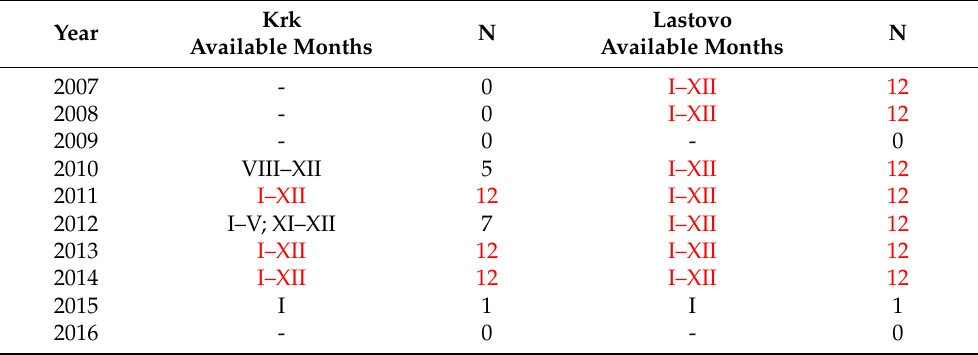
Table 1. Available complete monthly sea surface temperatures measured at Krk and